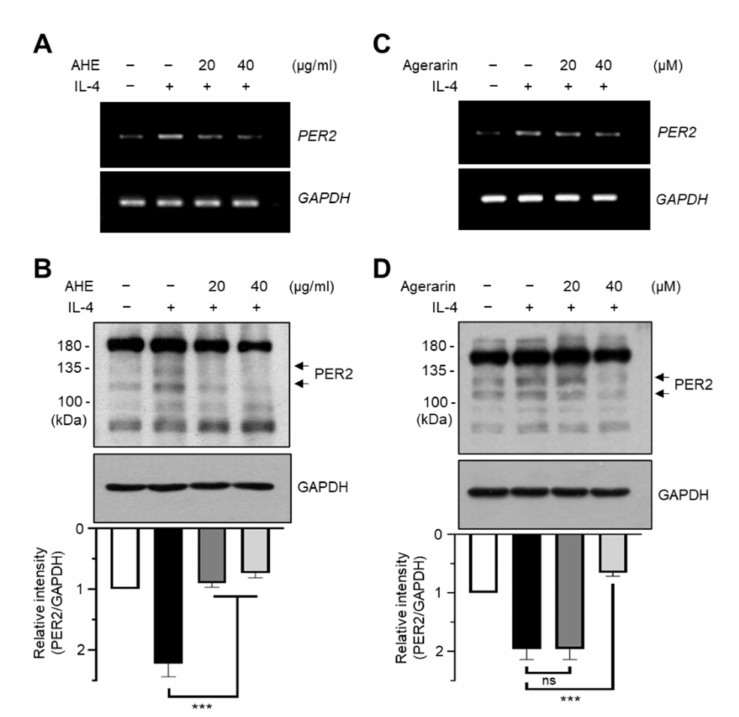
Figure 4. Effect of agerarin and AHE on the suppression of IL-4-induced PER2 expression. ( A , C ) HaCaT cells were pretreated with 20 or 40 µ g/mL AHE ( A ) and 20 or 40 µ M agerarin ( C ) for 30 min before stimulation in the presence (+) or absence ( − ) of 20 ng/mL IL-4. After 3 h, total RNA was isolated, and the levels of PER2 mRNA were measured by RT-PCR. The mRNA level of GAPDH was used as an internal control. ( B , D ) HaCaT cells were pretreated with AHE ( B ) and agerarin ( D ), as described above. After 24 h, whole-cell lysates were prepared and immunoblotted using anti-PER2 antibodies. GAPDH was used as the loading control. Band intensities of PER2 protein were measured using ImageJ and normalized to GAPDH. ns, not significant; *** p < 0.001 compared to IL-4-treated group ( n = 3) by Sidak’s multiple comparisons